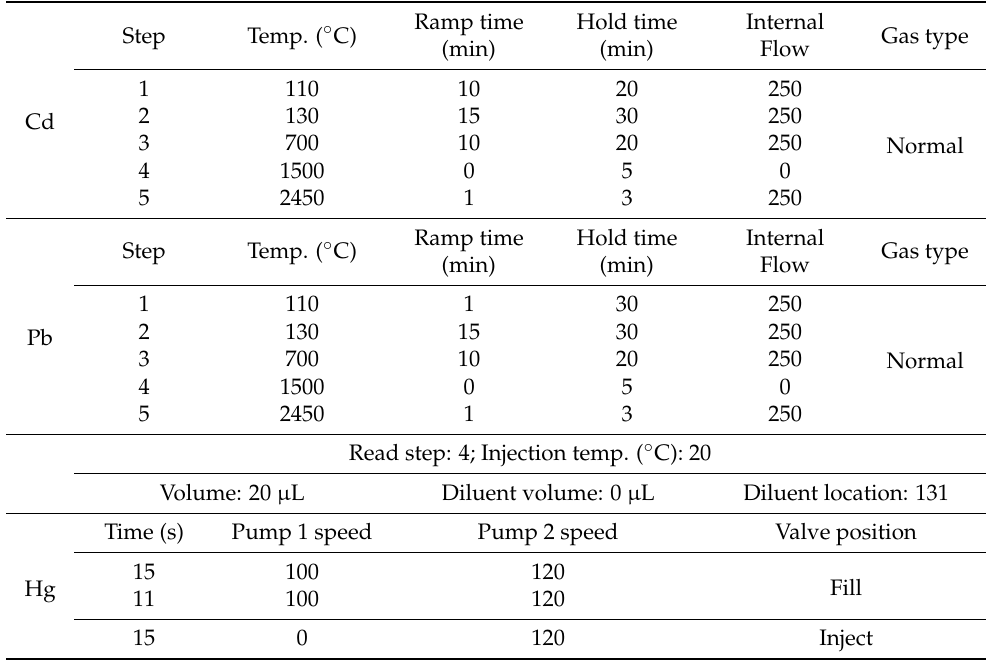
Table 3. Instrumental conditions of the graphite chamber for the determination of Cd and Pb and of the cold vapor for the determination of